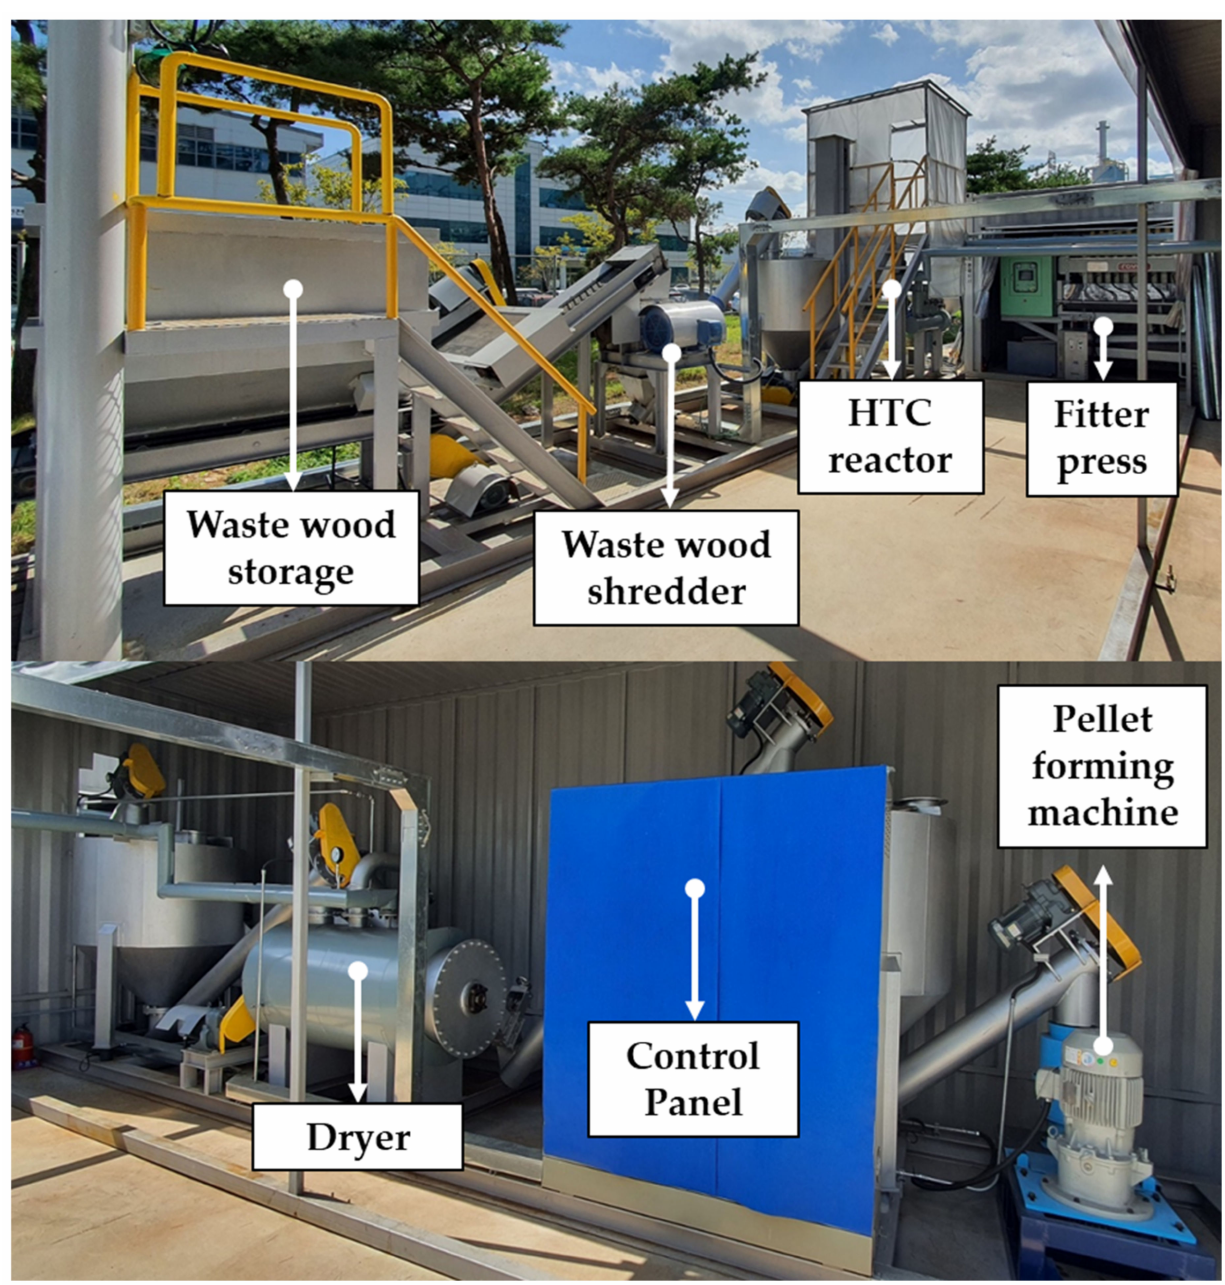
Figure 2. HTC biofuel production pilot